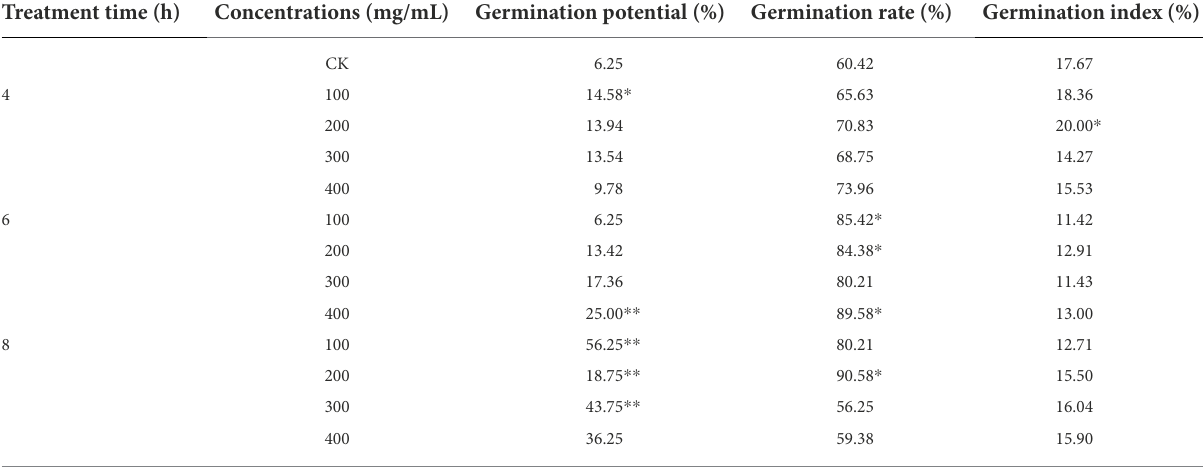
TABLE 2 Effects of GA3 treatment with different concentrations and durations on the germination of Yu537A. Treatment time